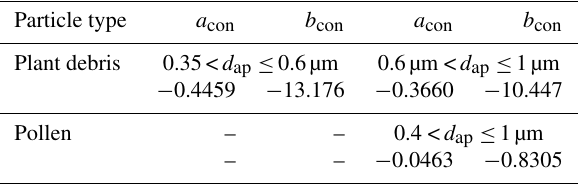
Table 1. New values of contact freezing constants in Eq. (4) for pollen and plant debris based on data from Hiranuma et al. (2015; plant debris) and Hoffmann (2015; pollen).